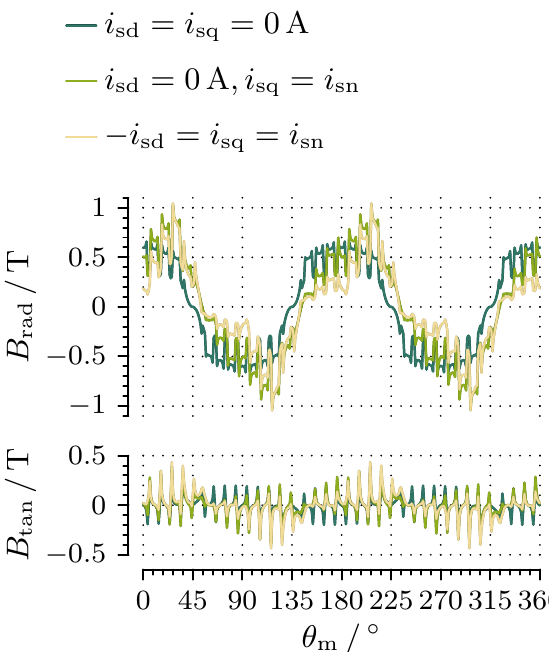
Figure 2. Variations in B rad and B tan observed along the sleeve at ¯ r sl for ϕ e = 0 ◦ at different load points.